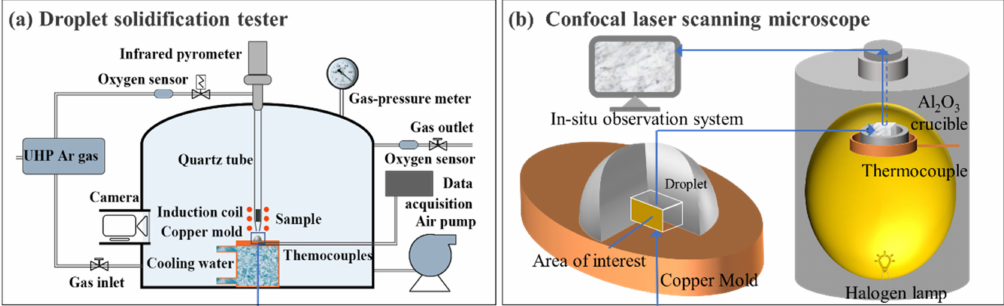
Figure 1. The schematic illustration of ( a ) droplet solidification tester and ( b ) confocal laser scanning microscope. Confocal laser scanning microscope (CLSM, VL2000DX-SVF18SP) (Yonekura